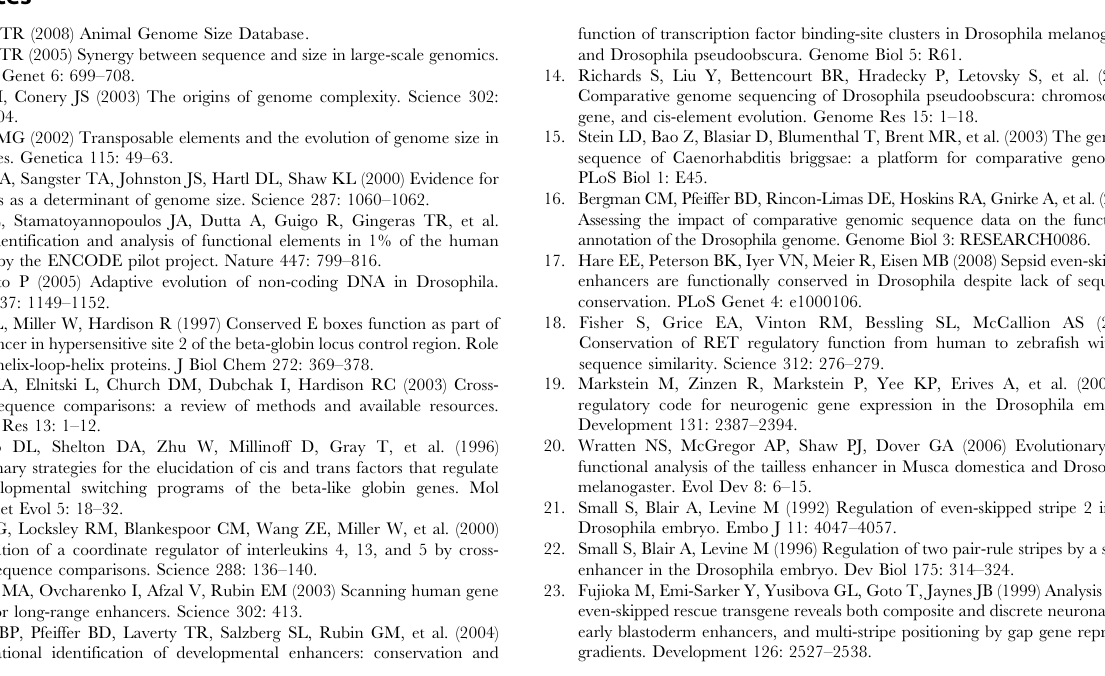
Table S1 Coding and non-coding fraction of major animal